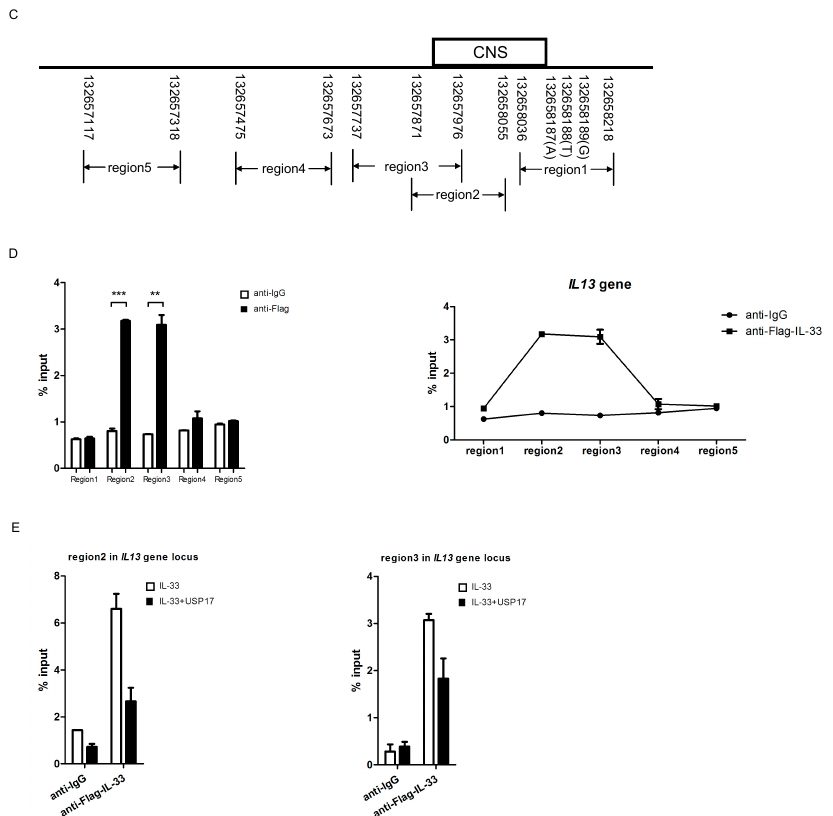
Figure 5. USP17 downregulates the chromatin binding of IL-33 to the CNS of IL13 gene locus. ( A ) Total RNA was extracted from the TAP-IL-33 and TAP-vector stable cell lines reverse transcribed following standard procedures, and the mRNA level of IL-13 was detected by qPCR. Cell lysates were used to detect the expression of IL-33 by immune blot; ( B ) The human IL13 genomic sequence was compared to house mouse, dog and cattle to find the conserved non-coding sequence (CNS) using the website [24]; ( C ) Five pairs of primers were designed based on the five regions, including the CNS, which localized before the translation initiation site (132658187 site); ( D ) HEK293T cells were transfected with Flag-IL-33. Cells were collected, and the rapid micro-chromatin immunoprecipitation assay (µChIP) was performed, as described in the Materials and Methods. Anti-Flag antibody and mouse IgG were used in this µChIP. ChIP and input samples were subjected to qPCR using the five pairs of primers described as above; ( E ) HEK293T cells were transfected with Flag-IL-33 and Myc-USP17 or an empty vector as a negative control. Cells were collected for µChIP analysis and then detected by qPCR using the two primers of region 2 and region 3 described as above. Data are representative of at least three independent experiments. *** p < 0.001. ** p < 0.01. Error bars represent mean ± SEM.